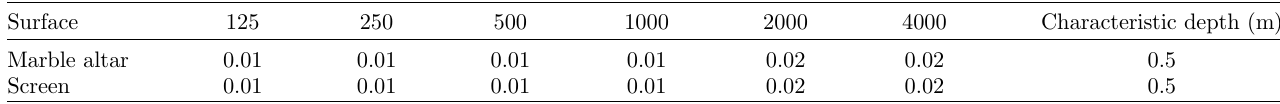
Table 4. Absorption coef fi cients and characteristic depth by octave band center frequency (Hz) for additional surfaces in the 1539 Thomaskirche GA model.